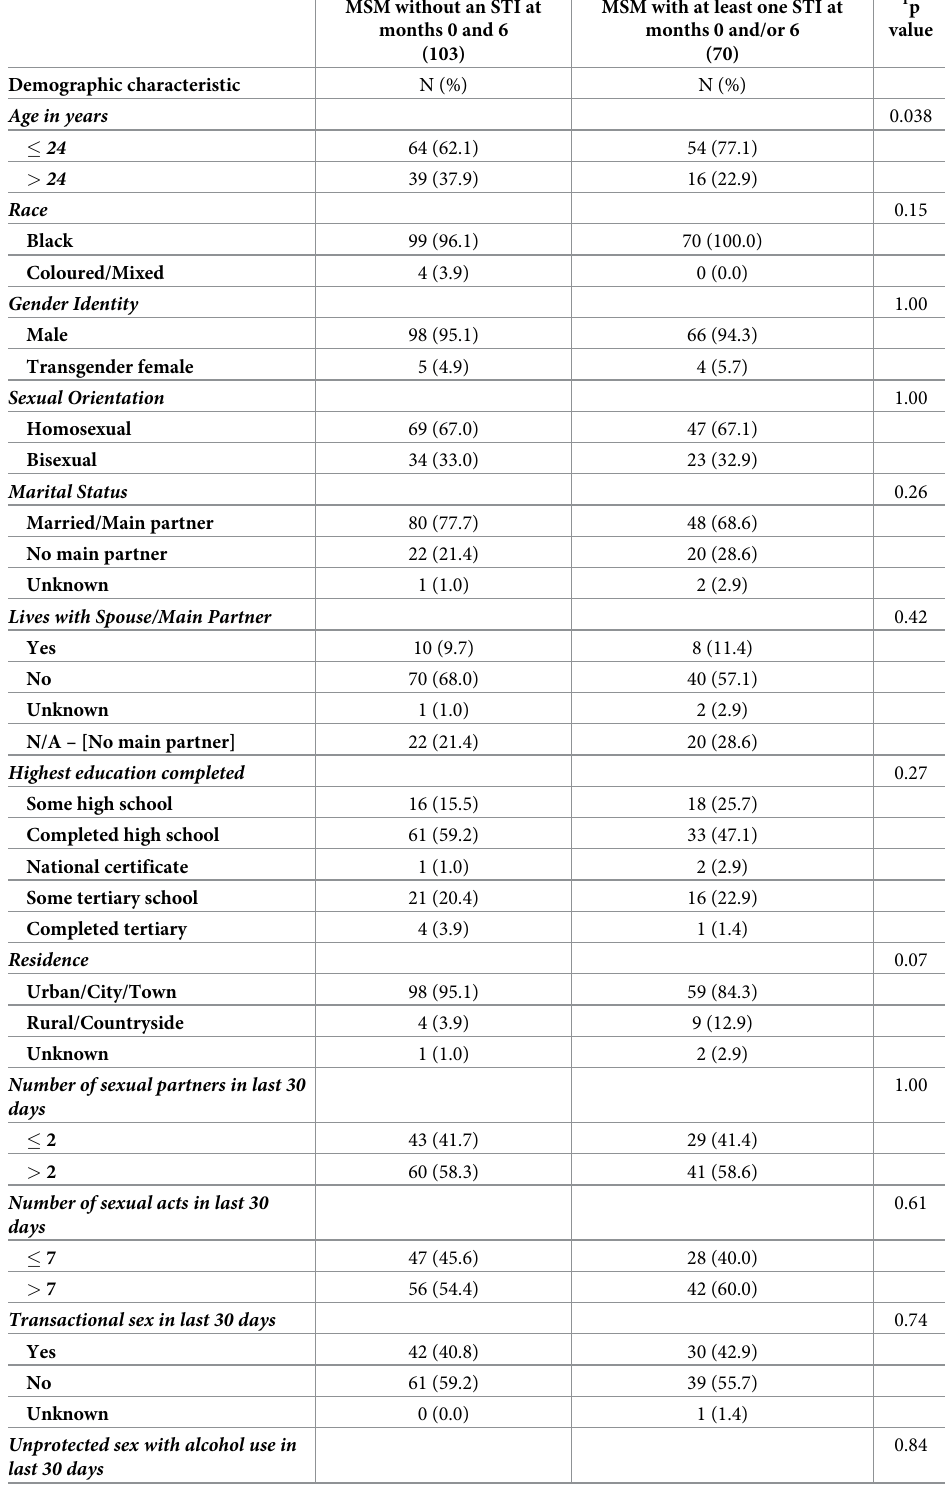
Table 4. STI acquisition factor analysis of demographic and month 0 behavioural risk variables for MSM sub-pop- ulation with at least one STI at months 0 and/or 6 vs. those without an STI at months 0 and 6. MSM without an STI at months 0 and